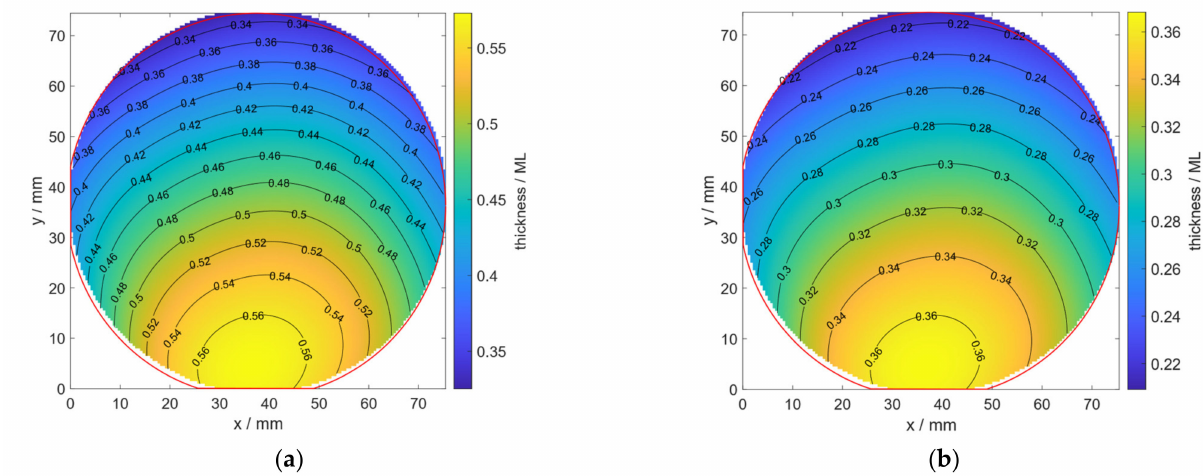
Figure A3. Simulated amount of Al with ( a ) 0.5 ML eq and ( b ) 0.3 ML eq thickness. The simulation is based on gradient growth and PL mapping of quantum wells, from which the effusion cell profiles are